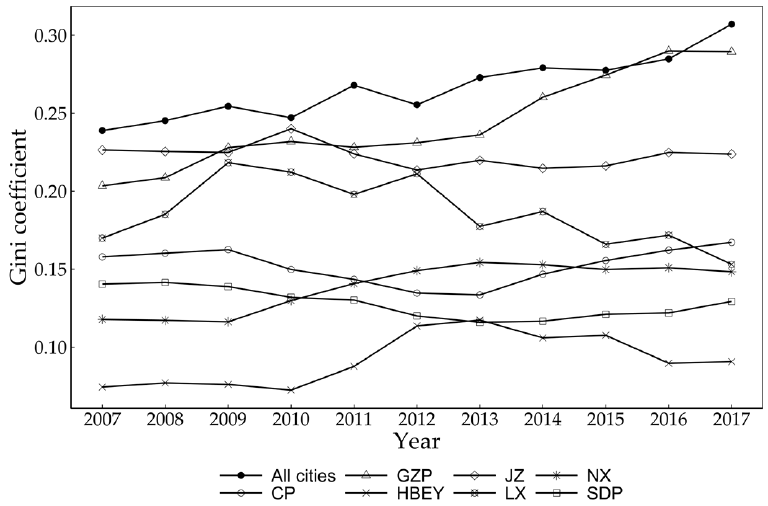
Figure 6. Changes in internal differences in the CEI of urban agglomerations in the YRB from 2007 to 2017.